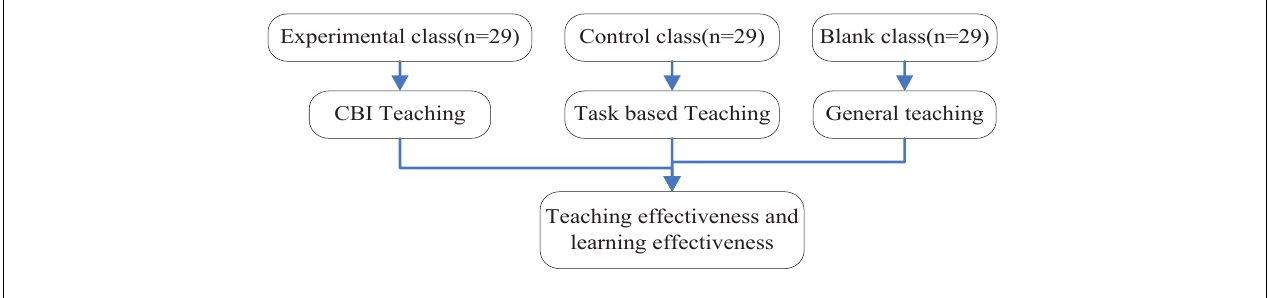
FIGURE 1 | Research